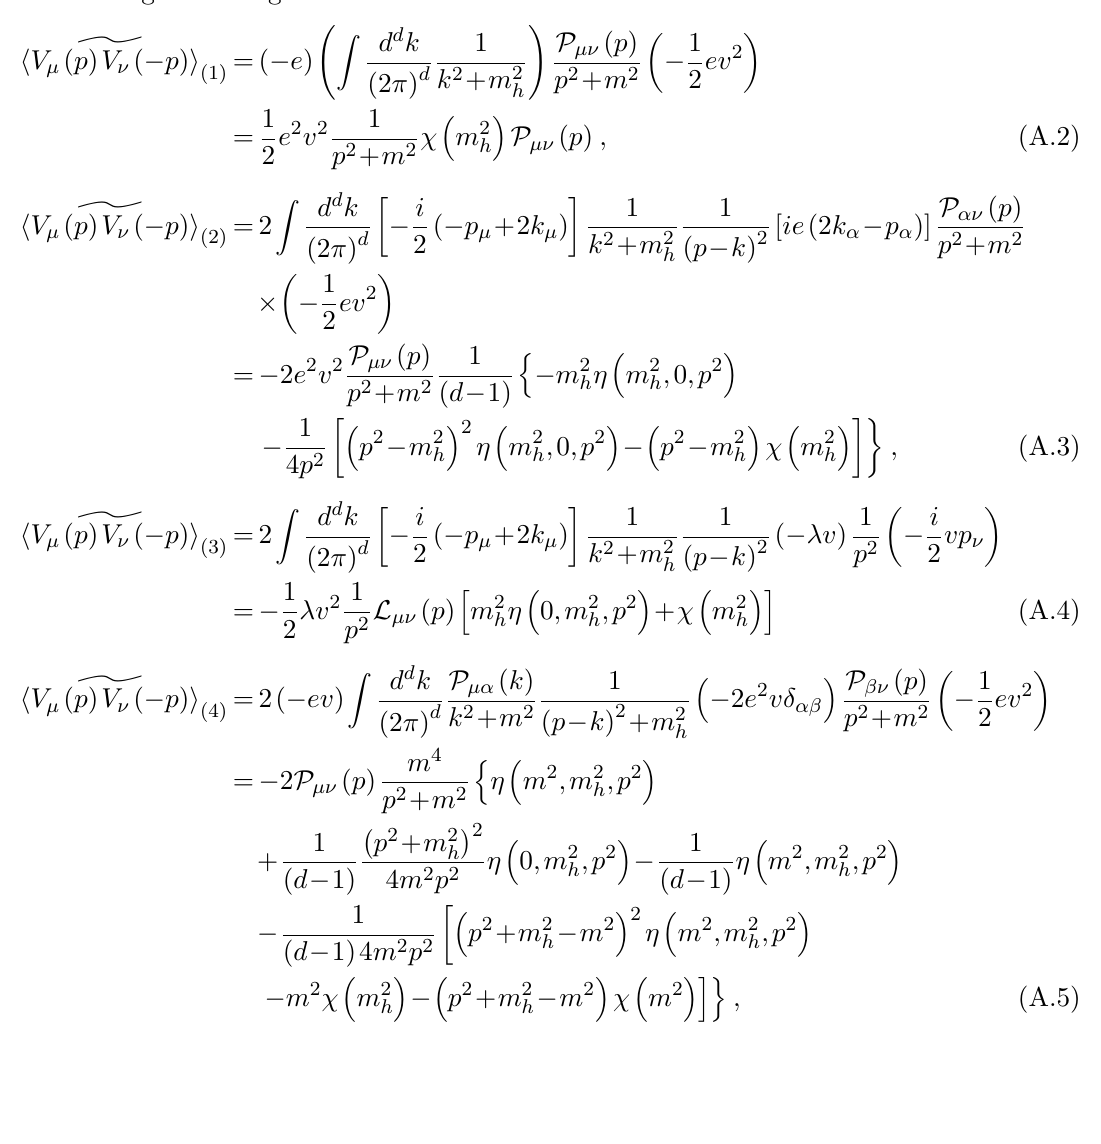
Figure 2 . Diagrams contributing to the one-loop two-point Green’s function of the V µ operator. Curly lines refer to the gauge field, solid ones to the Higgs field and dashed ones to the Goldstone field. For the diagrams of figure 2 we